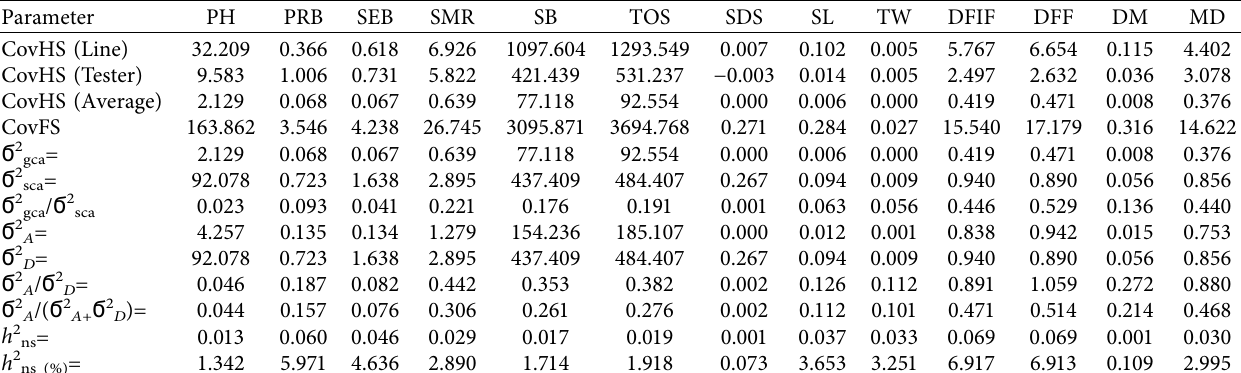
Table 13: Estimates of genetic variance for yield and its attributed traits in